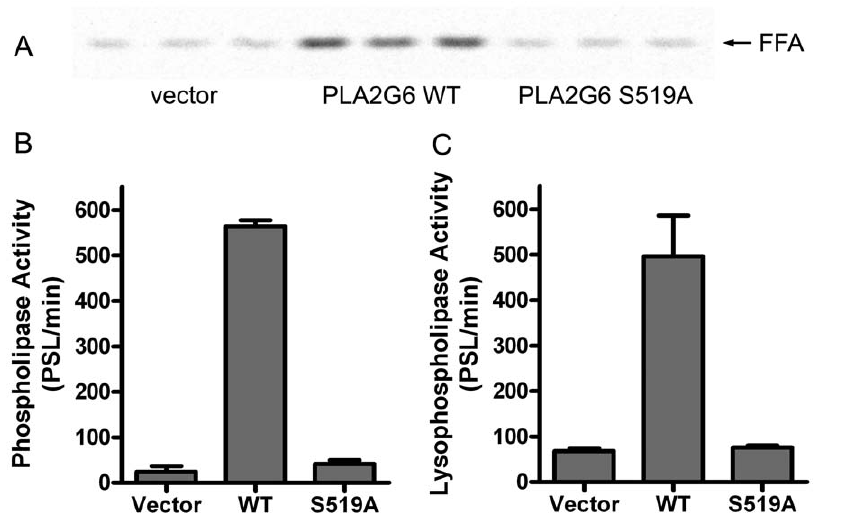
Figure 1. Recombinant human PLA2G6 protein catalyzes the hydrolysis of fatty acids from PC and LPC. (A) Purified recombinant protein preparations from cells transfected with an empty expression vector, WT PLA2G6 or S519A PLA2G6 were added to in vitro catalytic assays. Free fatty acids (FFA) released from 14 C-labeled 1-palmitoyl lysophosphatidylcholine were separated on TLC and detected using a phosphorimager. Incubation of substrate with WT PLA2G6 enzyme produces robust release of fatty acids compared to control preparations from vector-transfected cells. Catalytic activity is abolished by mutation of S519 in the lipase catalytic site. (B) Quantitation of catalytic activity for the 14 C-labeled phospholipid substrate 1-palmitoyl-2-oleyl phosphatidylcholine. (C) Quantitation of activity for 14 C-labeled LPC lysophospholipid substrate. Fatty acid release in catalytic assays was quantitated from the phosphorimager screen in photostimulated luminescence (PSL) units, and the graphs indicate the rate of hydrolysis for each substrate, measured by the increase in PSL units per min of incubation time in each assay. Since the PLA2G6 protein concentrations, radiochemical specific activities and substrate concentrations were the same in both assays, the results indicate that the catalytic rates for the two substrates are similar.